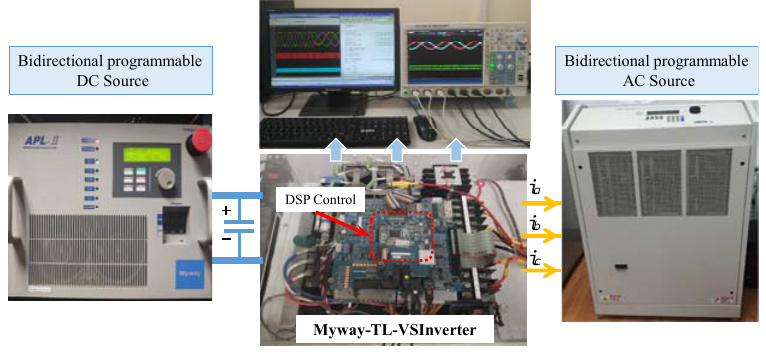
Figure 10. Experimental setup for the grid ‐ side converter.